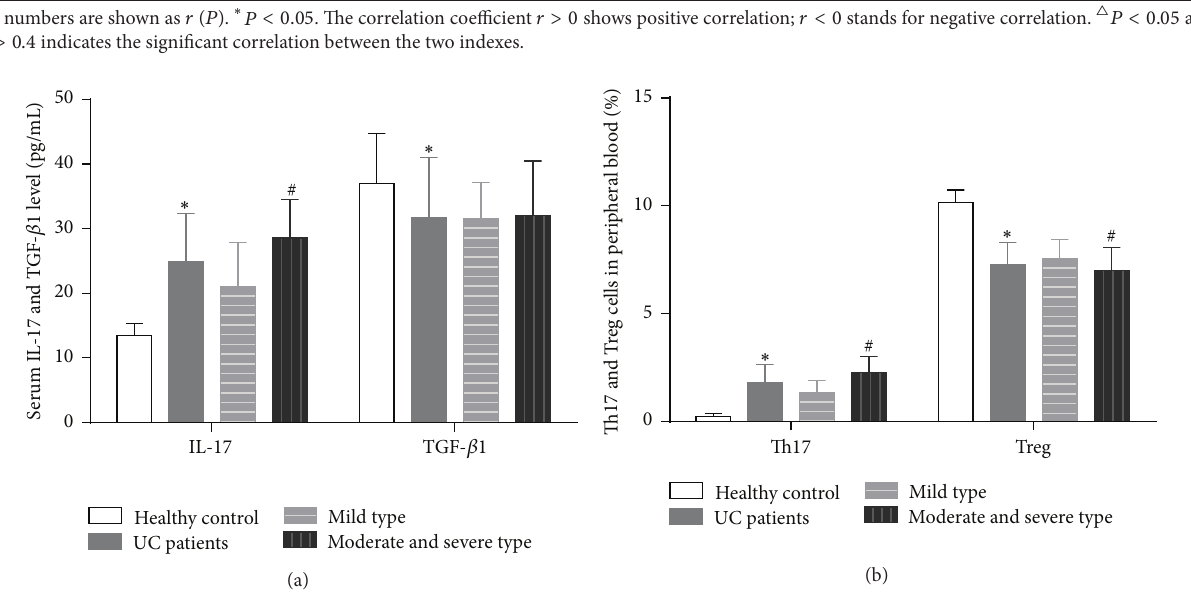
Figure 2: Serum IL-17 and TGF- 𝛽 1 level (pg/mL) and percentage of Th17 and Treg cells in peripheral blood (%) in healthy control subject, UC patients, mild type, and moderate and severe subgroup. (a) Serum IL-17 and TGF- 𝛽 1 level (pg/mL) in healthy control subject, UC patients, mild type, and moderate and severe subgroup. (b) Percentage of Th17 and Treg cells in peripheral blood (%) in healthy control subject, UC patients, mild type, and moderate and severe subgroup. ∗ presents 𝑃 < 0.05 between UC patients and healthy control subject; # stands for 𝑃 < 0.05 between mild type and moderate and severe type